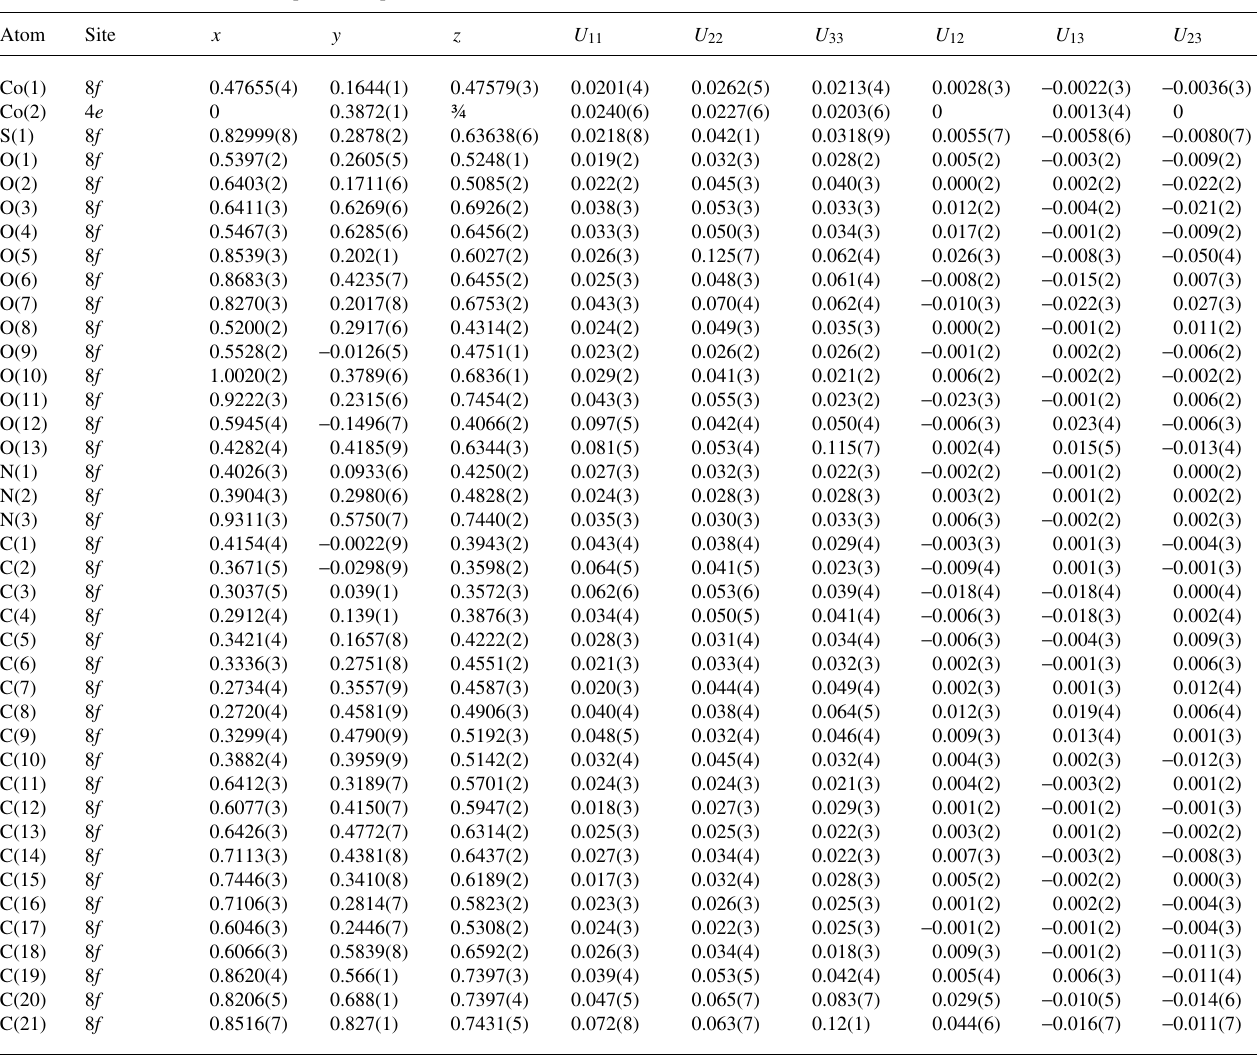
Table 3. Atomic coordinates and displacement parameters (in Å 2 ) .